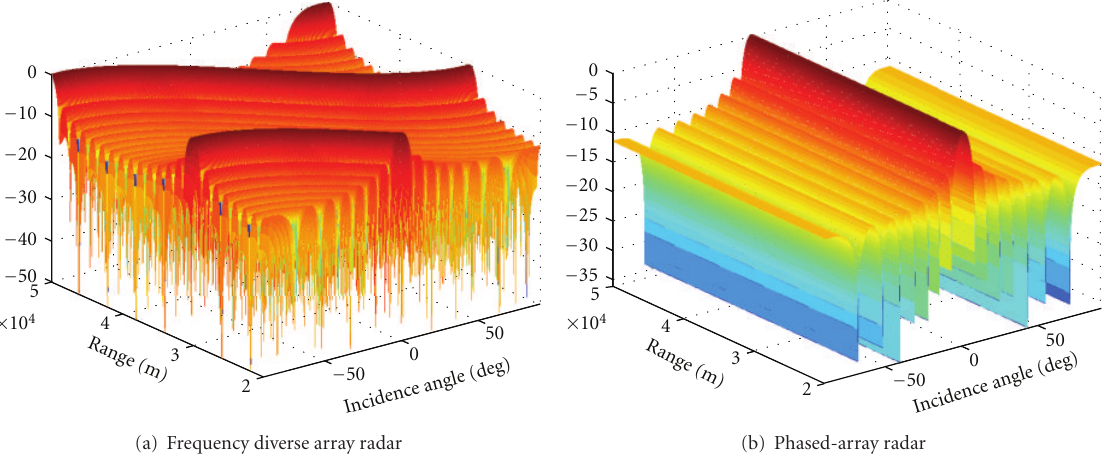
Figure 2: Comparative beampattern between FDA and conventional phased array with Δ f = 15kHz.